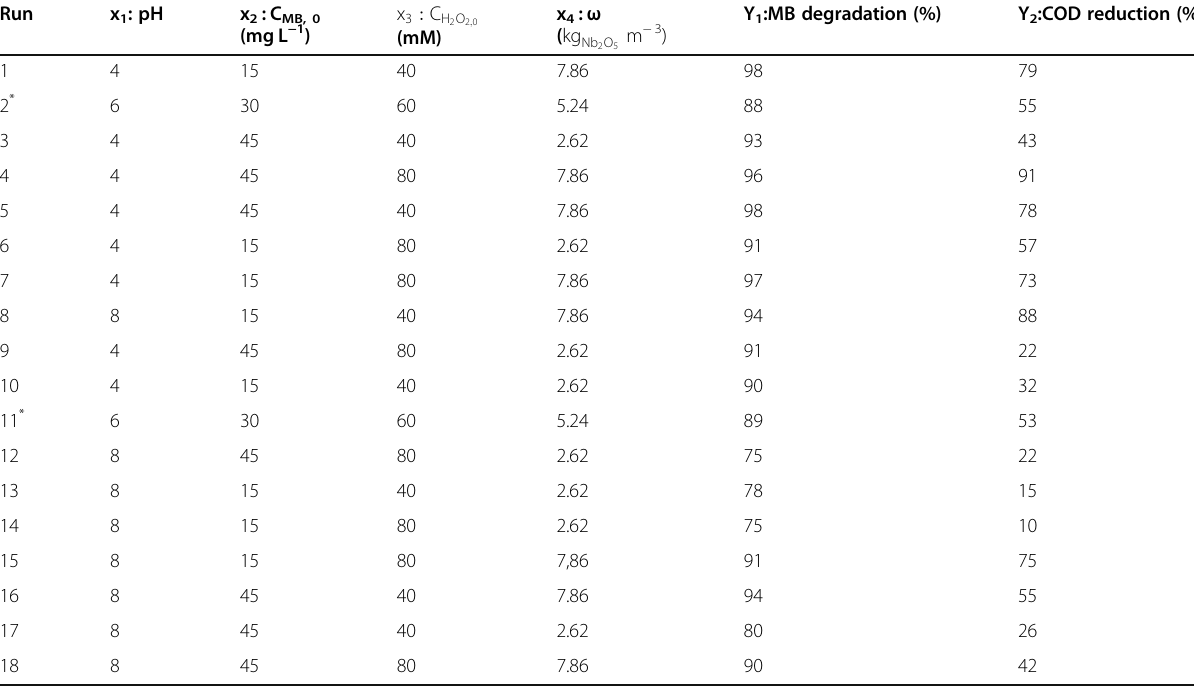
Table 2 Experimental variables and responses for MB degradation using Nb 2 O 5 /Al 2 O 3 /Al catalyst